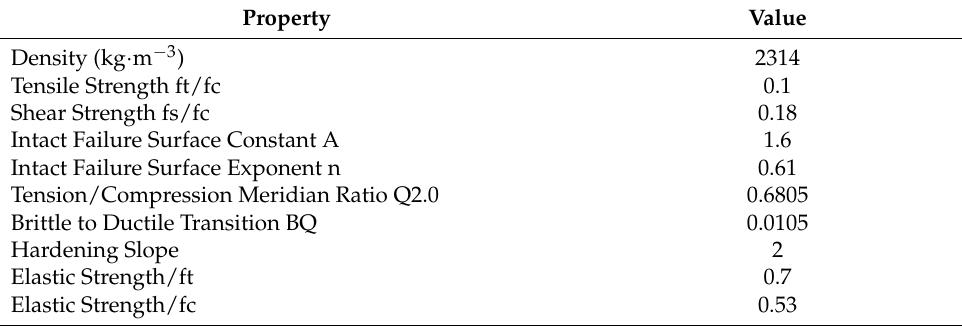
Table 2. Basic concrete material parameters.